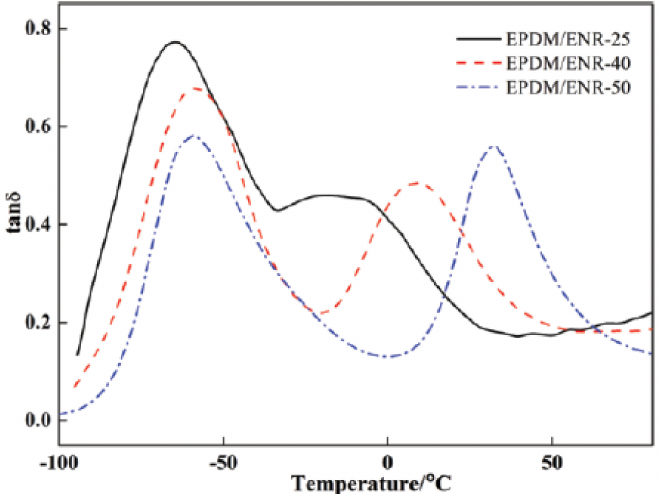
Figure 18. Temperature dependence of the damping loss factor (tan δ ) for EPDM/ENRs (75/25) blends with ENRs of different epoxidation degree [55].